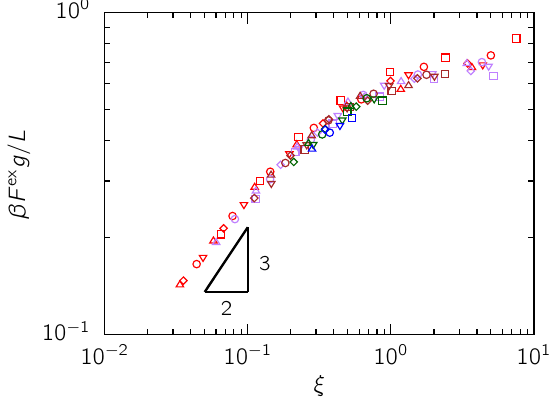
Figure 5. The excess free energy of real chains confined in rectangular channels. The L p / w values shown are L p / w = 10 ( (cid:3) ), L p / w = 12.5 ( (cid:53) ), L p / w = 15 ( (cid:13) ), L p / w = 17.5 ( (cid:5) ) and L p / w = 20 ( (cid:52) ). Different colors indicate different A eff / D eff ratios: red (1), purple (1.5), brown (2), green (3) and blue (4). A power law fit of our data for ξ < 0.1 reveals an exponent of 0.559 ± 0.016. All the data points satisfy the condition D eff ≤ A eff ≤ 2 L p